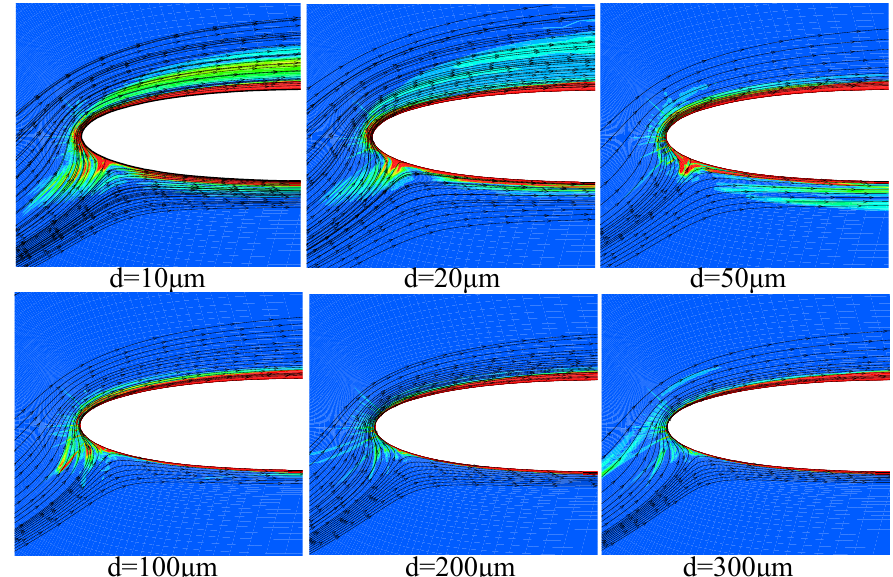
Figure 8. Streamline and vortex volume of the leading edge of airfoil under different diameter par ‐ ticles.